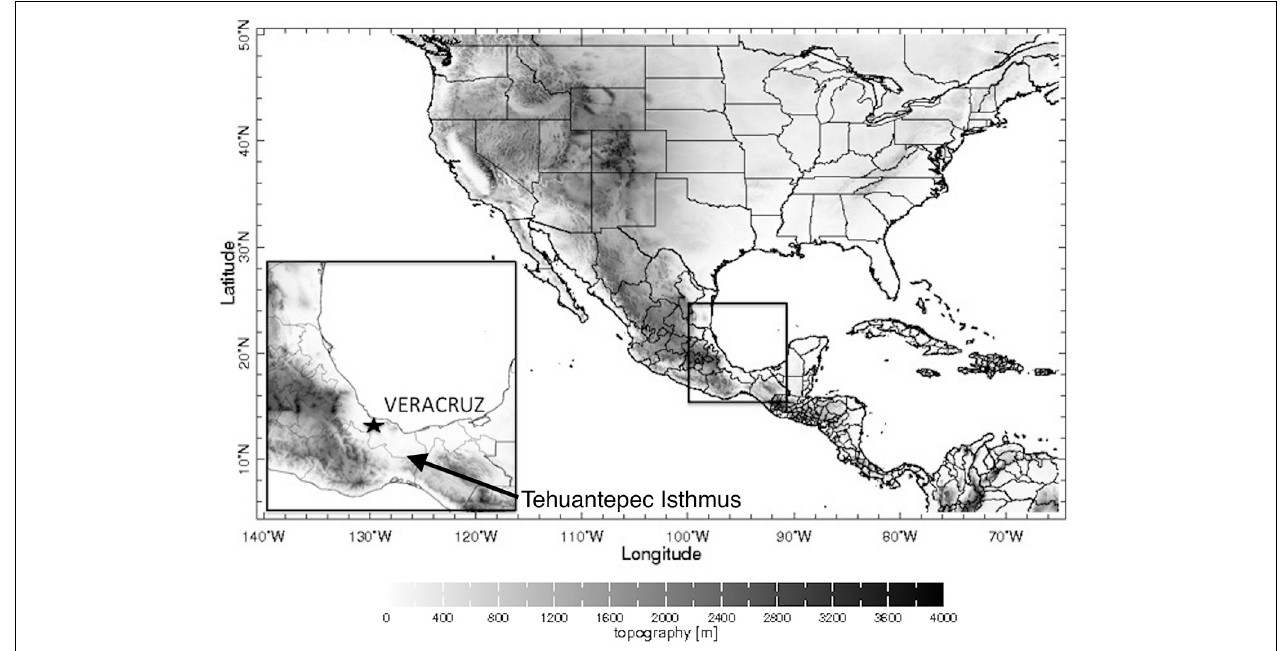
FIGURE 1 | Topography over North America. The location of the city of Veracruz, Mexico and the Tehuantepec Isthmus are indicated.